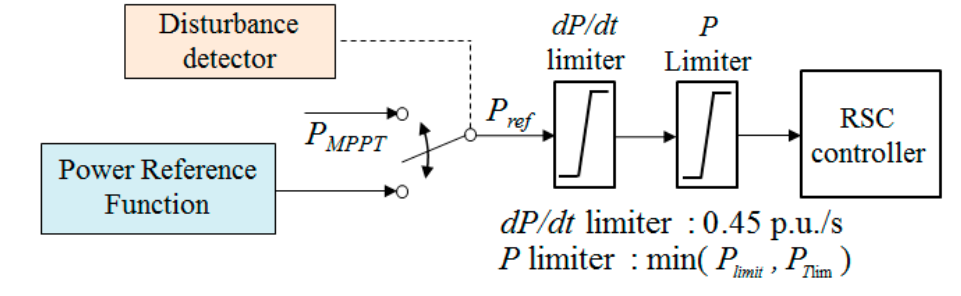
Figure 2. Control concept of SIC.